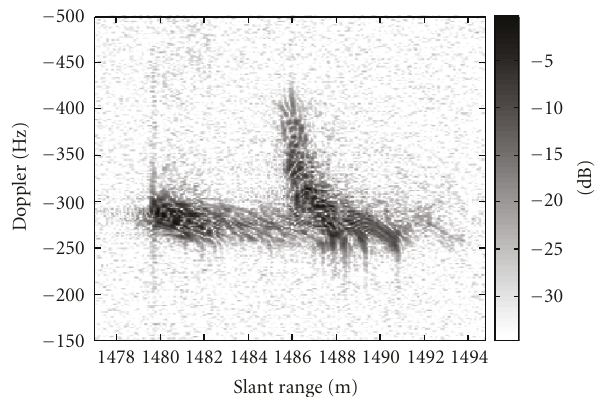
Figure 10: ISAR image after applying RDA to the real data for the entire CPI.